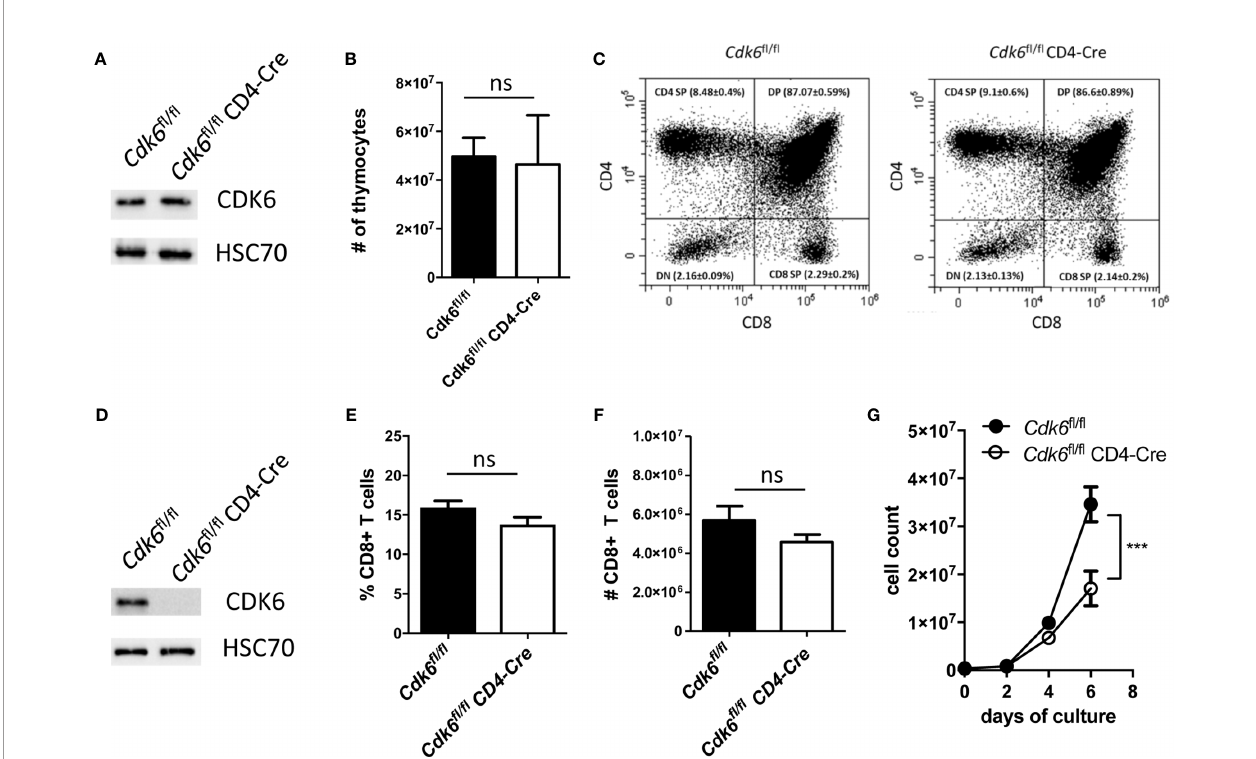
FIGURE 3 | Cdk6 fl / fl CD4-Cre mice do not show a defect in thymic T cell development and splenic CD8+ T cell numbers, while in vitro expansion of CD8+ T cells is impaired. (A) Thymocytes were lysed from Cdk6 fl / fl and Cdk6 fl / fl CD4-Cre mice for western blot analysis of CDK6 protein levels. HSC70 served as a loading control. (B) Absolute numbers of thymocytes were analyzed in Cdk6 fl / fl and Cdk6 fl / fl CD4-Cre mice (n=4-7). (C) The frequencies of CD4/CD8 double-negative (DN), CD4/CD8 double-positive (DP), CD4 single-positive (CD4 SP) and CD8 single-positive (CD8 SP) thymocytes were analyzed by fl ow cytometry in Cdk6 fl / fl CD4-Cre mice and Cdk6 fl / fl controls (n=4-7). Representative dot plots are shown. Figure S2A shows the corresponding bar graph with mean ± SEM values. (D) Splenic CD8+ T cells from Cdk6 fl / fl and Cdk6 fl / fl CD4-Cre mice were cultured for six days and lysed for western blot analysis of CDK6 protein levels. HSC70 served as a loading control. (E, F) Percentage (E) and total numbers (F) of splenic CD3+CD8+ T cells were analyzed by fl ow cytometry in Cdk6 fl / fl and Cdk6 fl / fl CD4-Cre mice (n=7-9). (G) Splenic CD8+ T cells were isolated from Cdk6 fl / fl and Cdk6 fl / fl CD4-Cre mice, activated with a CD3/ a CD28 for 48h and cultured in the presence of IL-2. Numbers of CD8+ T cells were analyzed every two days during the culture (n=4). (B, E, F) Bar graphs represent mean ± SEM, pooled from 2-3 independent experiments. (G) Symbols in growth curves represent mean ± SEM, pooled from two independent experiments; ***p < 0.001 (for comparison on d6), two-way ANOVA. ns, not signi fi